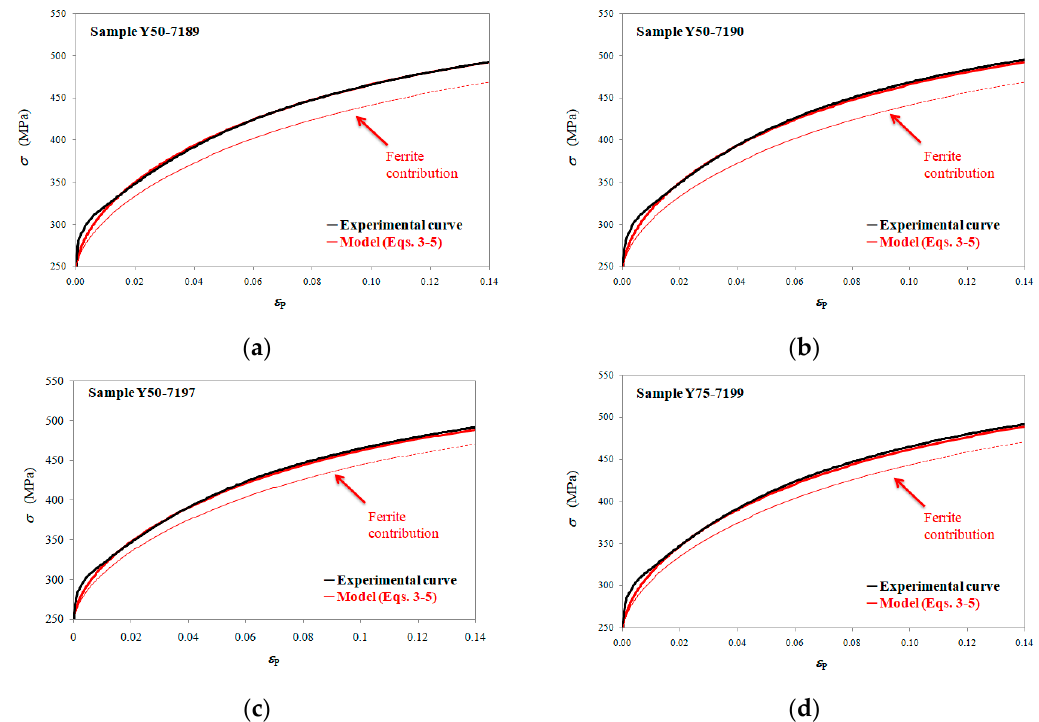
Figure 4. Modelling the tensile flow curves of the GJS 400 reported in Figure 3 using the average microstructure values in Table 2: ( a ) and ( b ) Y 50 mm with the average ferrite grains size = 48.6 µ m, and average pearlite volume fraction = 4.0%; ( c ) and ( d ) Y 75 mm with average ferrite grains size = 47.7 µ m, and average pearlite volume fraction = 3.0%.